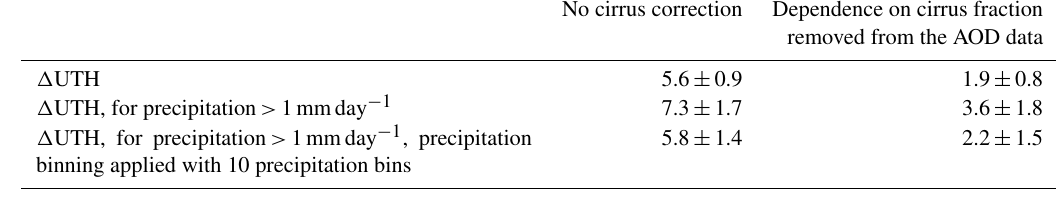
Table 1. Impact of different choices on the results. (cid:49) UTH was calculated as (cid:49) UTH = UTH[AOD ≥ median(AOD)] − UTH[AOD < median(AOD)] east of China in June, July and August in 2007–2013 and is expressed as %-units. 90% confidence interval is calculated from the standard error of the monthly mean (cid:49) UTH.